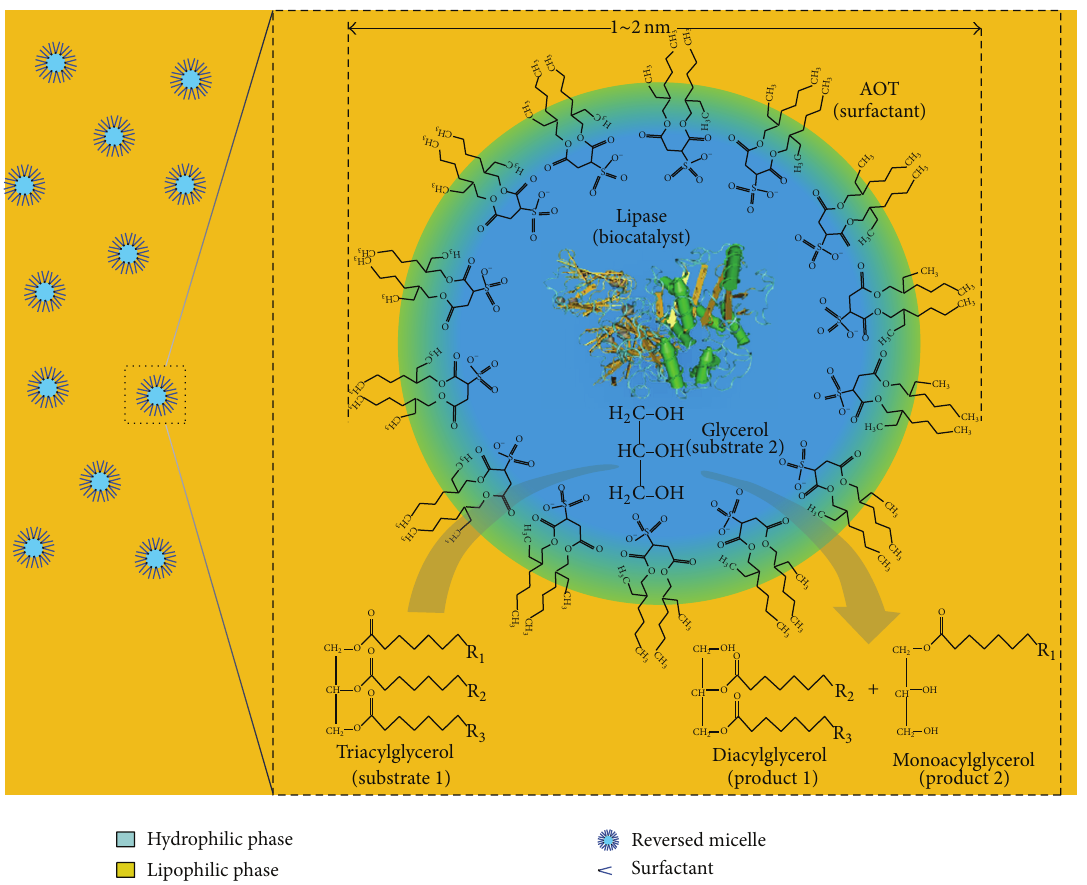
Figure 7: Schematic representation of AOT/isooctane reversed micellar system